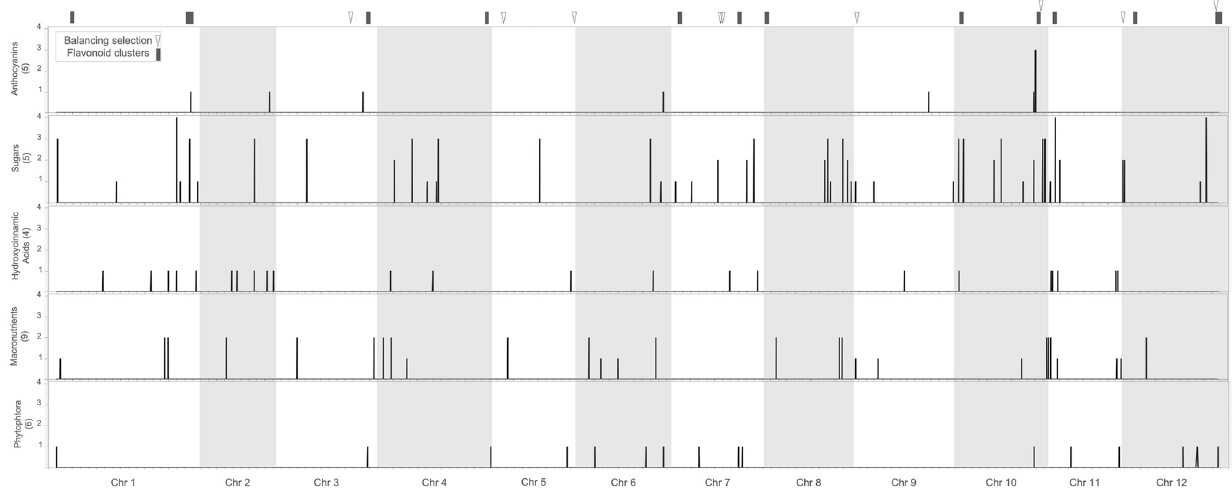
Fig 3. Genomic architecture of variation in anthocyanins and other agronomic traits. Each horizontal panel corresponds to a set of traits, with the number of traits in the set indicated in parenthesis. In the X axis we present the position of the SNPs across the genome and in the Y axis we show the number of traits significant for a particular SNP. In the top we indicate the location of 1 Mb intervals showing clusters ( > 3 genes) of flavonoid genes as well as footprints of balancing selection according to Tajima’s D statistic.